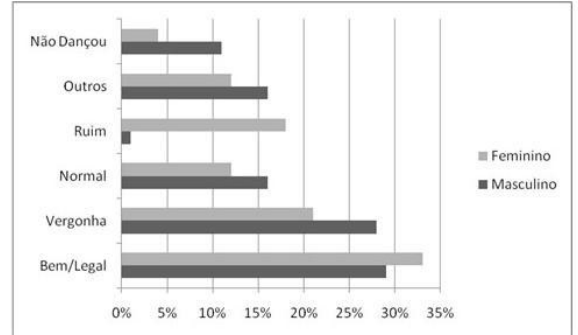
Figura 3. Sensação percebida pelo participante quando teve que dançar separadamente ou